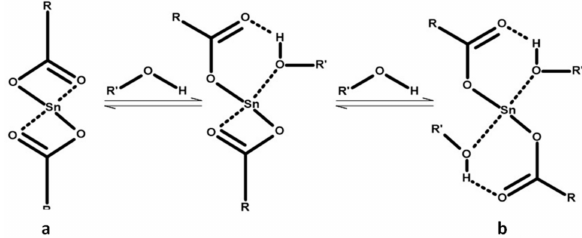
Figure 6. Mechanism of formation of the tin-alkoxide